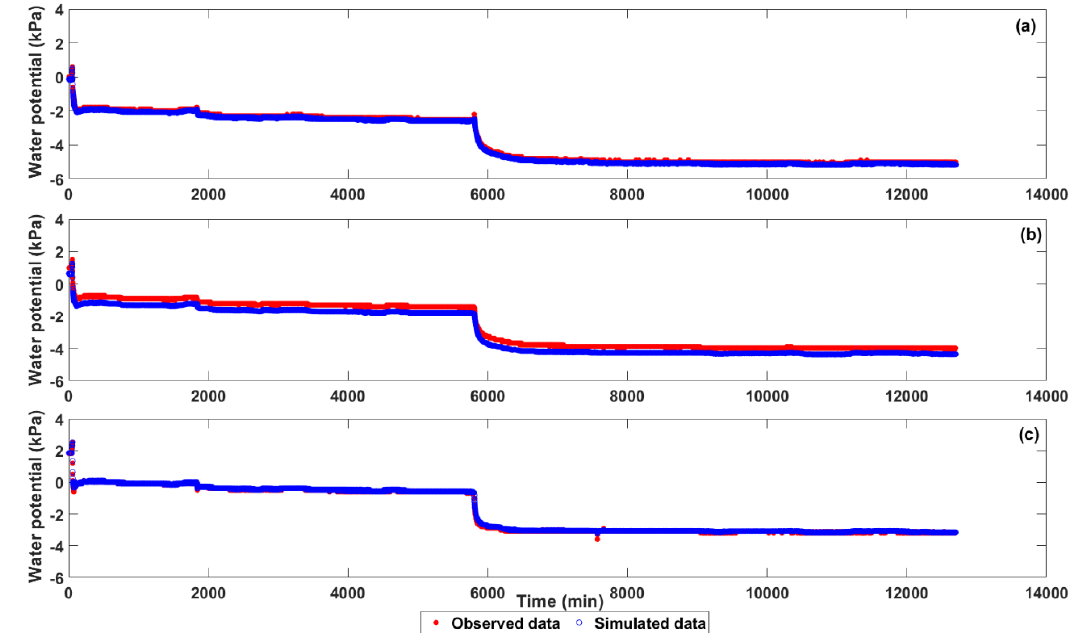
Table 4. Statistical comparison of observed and simulated data for validation of the model. Statistical Analyses